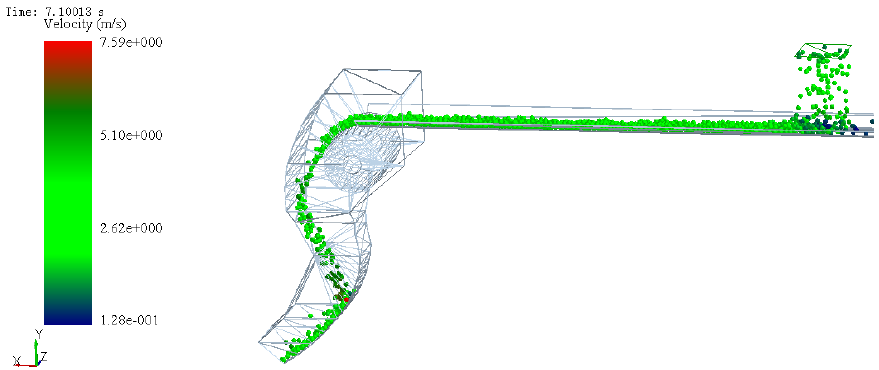
Figure 2. Simulation diagram of coke speed.